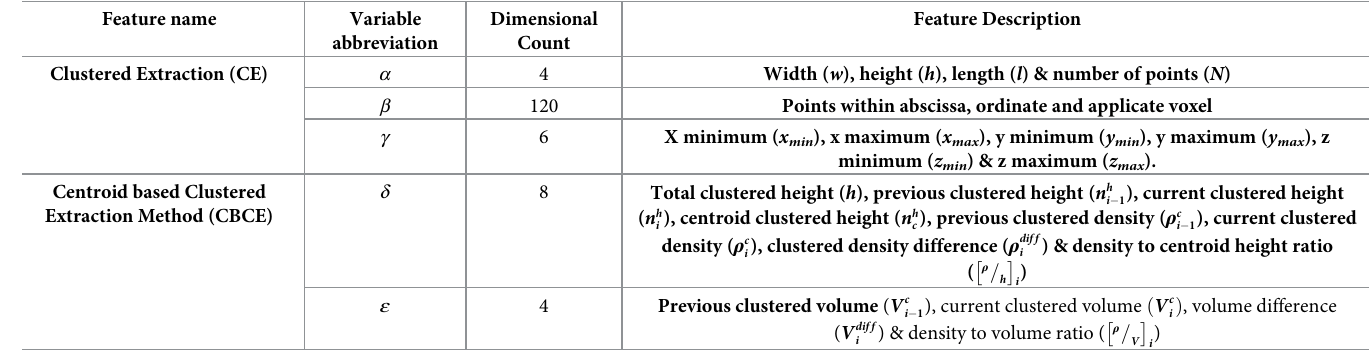
Table 2. Summary of features